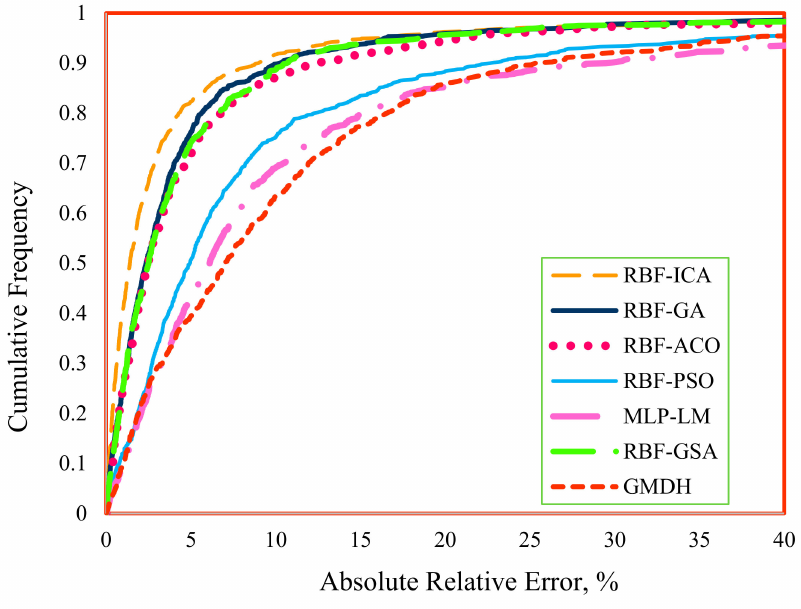
Figure 2. Cumulative frequency curve for the models proposed in this research. Figure S3 (panels a–g) depicts the graphical illustration of the APRE of the applied models. The red color indicates the maximum error in the IFT estimation, and the purple color represents the smallest error in model outputs. The peaks indicate the value of abso- lute percent relative error reported at each temperature and different molecular